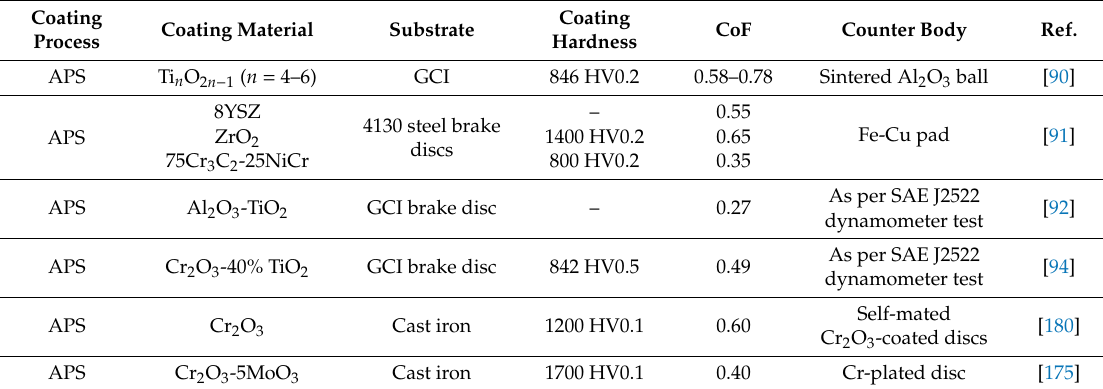
Table 3. Summary of sliding wear studies involving oxide-based coatings on brake discs and cast-iron